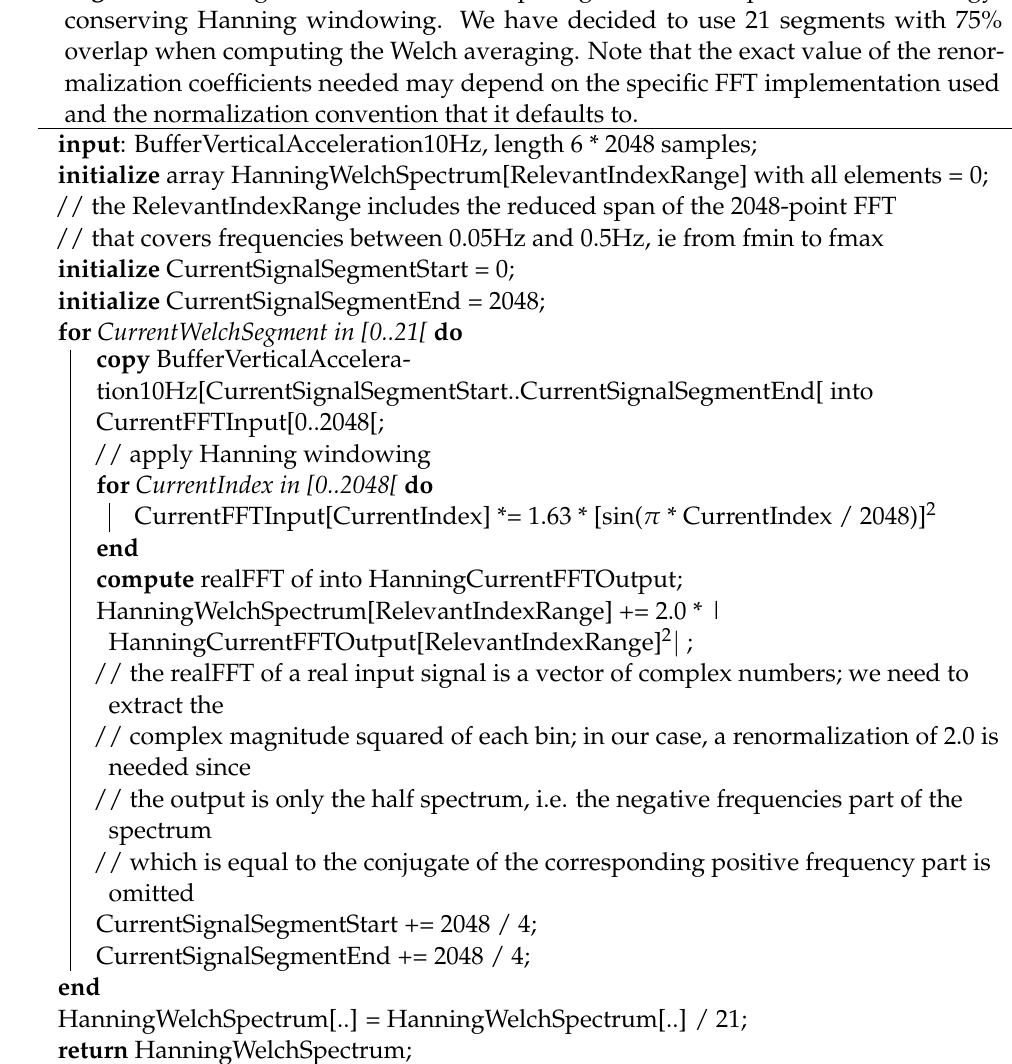
Algorithm 2: Algorithm used for computing the Welch spectrum with energy- conserving Hanning windowing. We have decided to use 21 segments with 75% overlap when computing the Welch averaging. Note that the exact value of the renor- malization coefficients needed may depend on the specific FFT implementation used and the normalization convention that it defaults